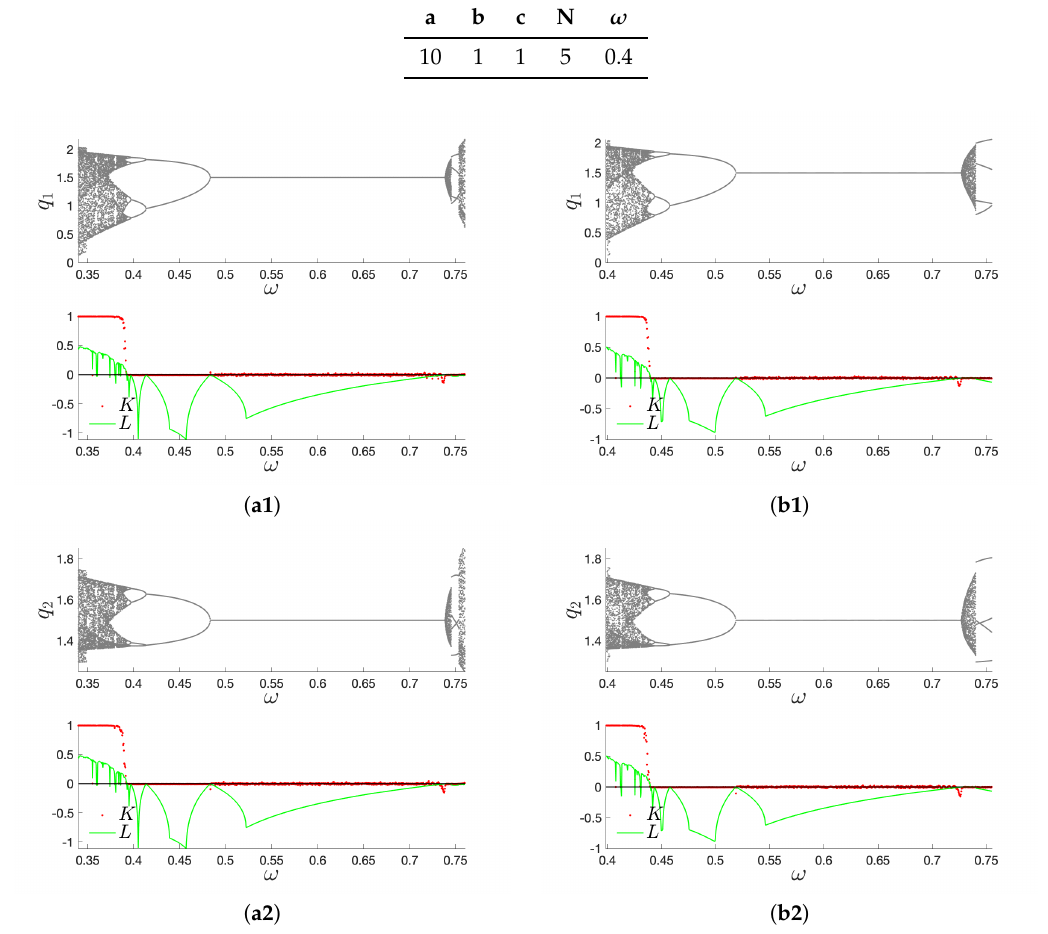
Figure 2. HCOM Equation (8) system’s BD ω , K , and L of q 1 ( a1 , b1 ) and q 2 ( a2 , b2 ), for γ 0 = 0.48 ( a1 , a2 ), and γ 1 = 0.5244 ( b1 , b2